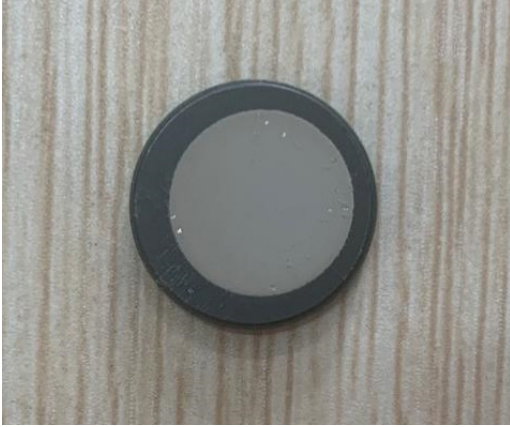
Figure 1. Sintered aluminum electrode sample.